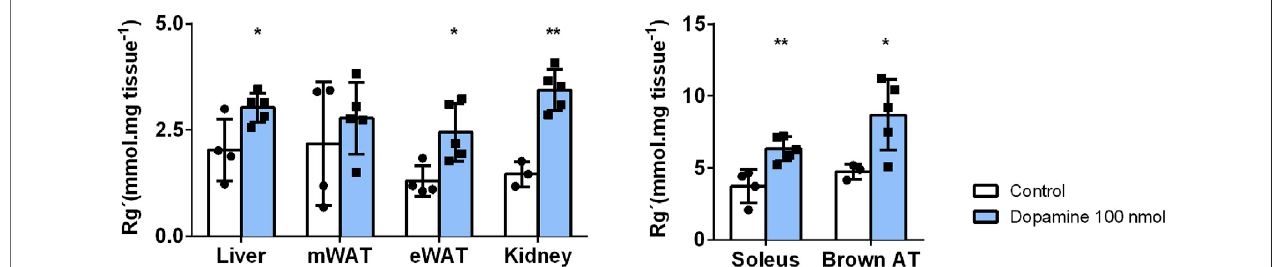
FIGURE 2 | Effects of in vivo dopamine administration on glucose uptake in insulin-sensitive tissues. Exogenous dopamine administration at 100 nmol enhances glucose uptake signi fi cantly in all tissues except for mWAT. Values and bars represent mean ± SD. One-way ANOVA with Dunnet ’ s post hoc comparisons test was performed, where *indicates differentfromthe controlgroup. Levels ofsigni fi cance:* p < 0.05; ** p < 0.01; *** p < 0.001.mWAT,mesenteric whiteadipose tissue;eWAT, epididymal white adipose tissue; and BAT, brown adipose